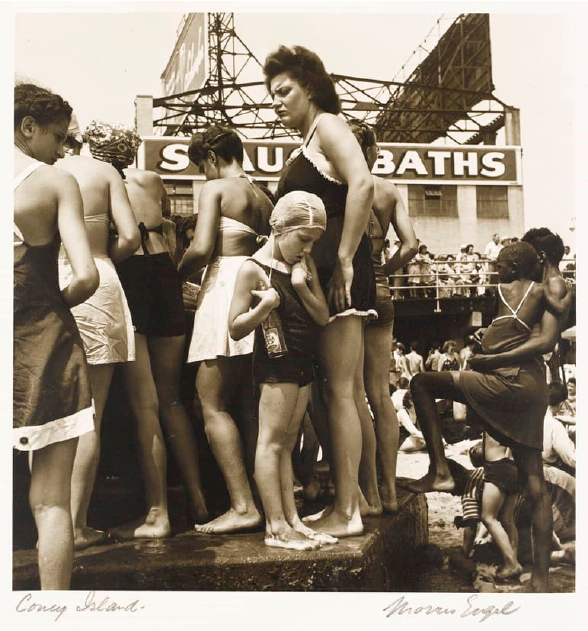
Figure 4. Morris Engel, 'Water Fountain, Coney Island’, 1938. Gelatin silver print. 19.4 cm × 18.7 cm. © 2019. Photo The Jewish Museum/Art Resource/Scala, Florence.